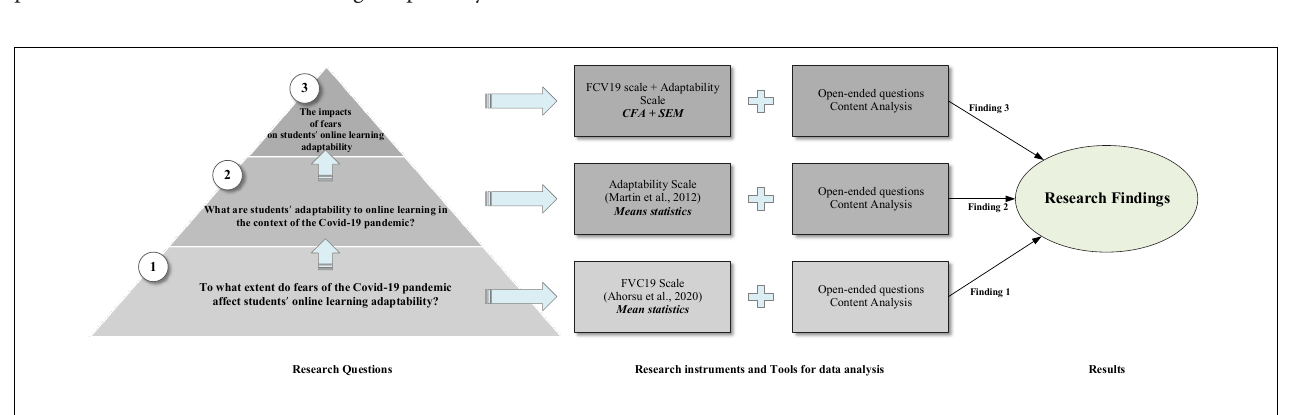
FIGURE 1 | Research